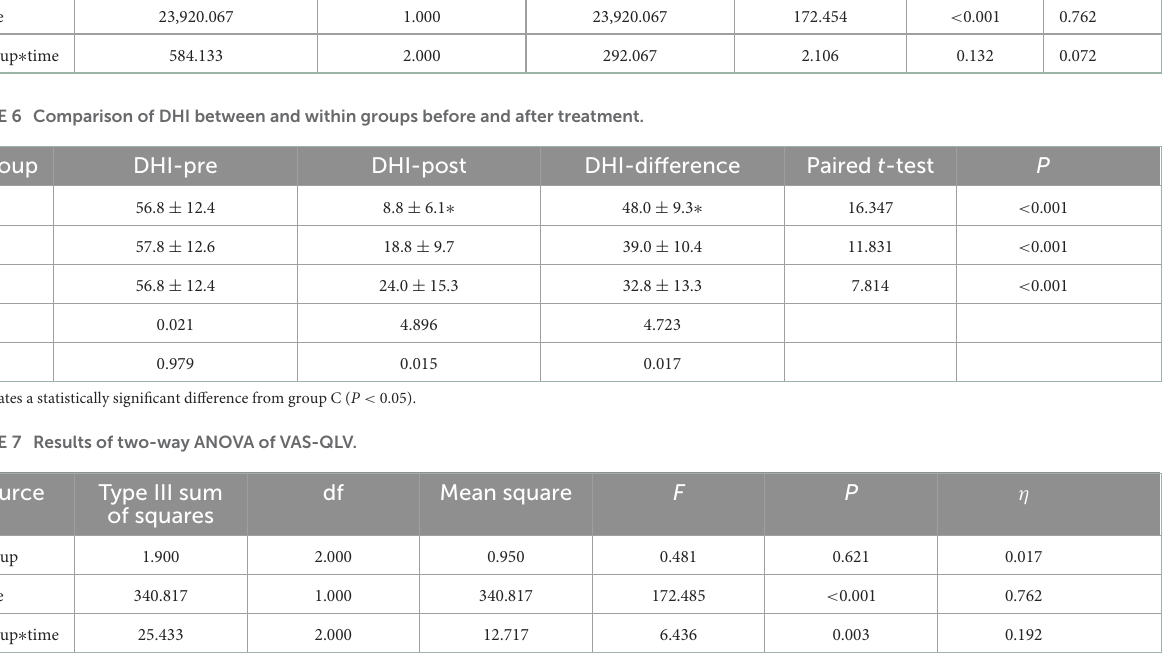
TABLE 8 Comparison of VAS-QLV between and within groups before and after treatment. Group